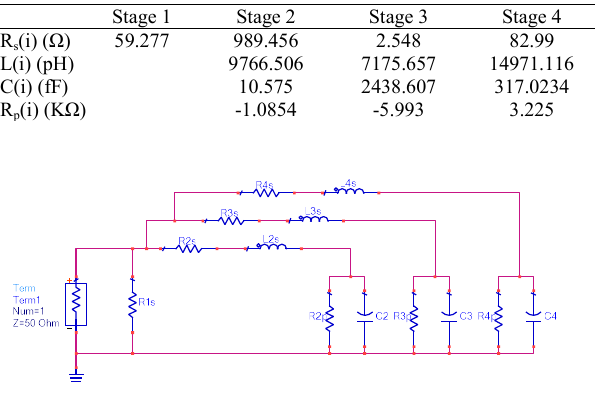
Figure 17: Spice circuit for patch antenna with CRR.